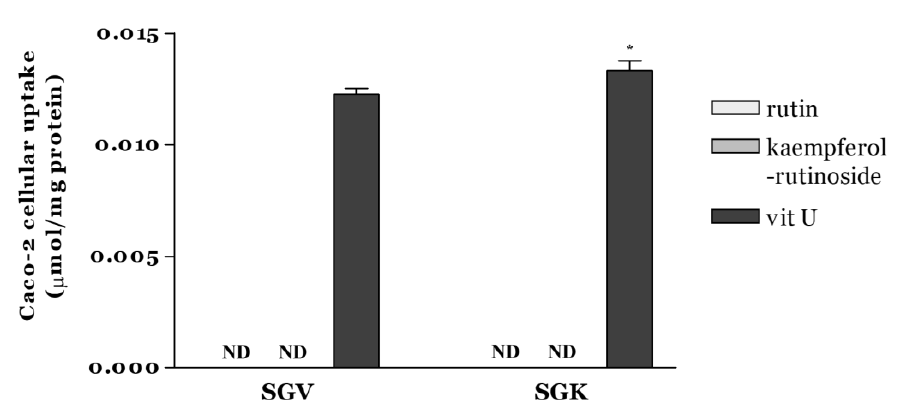
Figure 3. Caco-2 cellular uptake of rutin, kaempferol-rutinoside, and vit U from SGV and SGK after 2 h incubation expressed as µmol/mg protein. * indicates a significant difference between samples ( p < 0.05). ND (Not detectable): amount below the limit of detection.